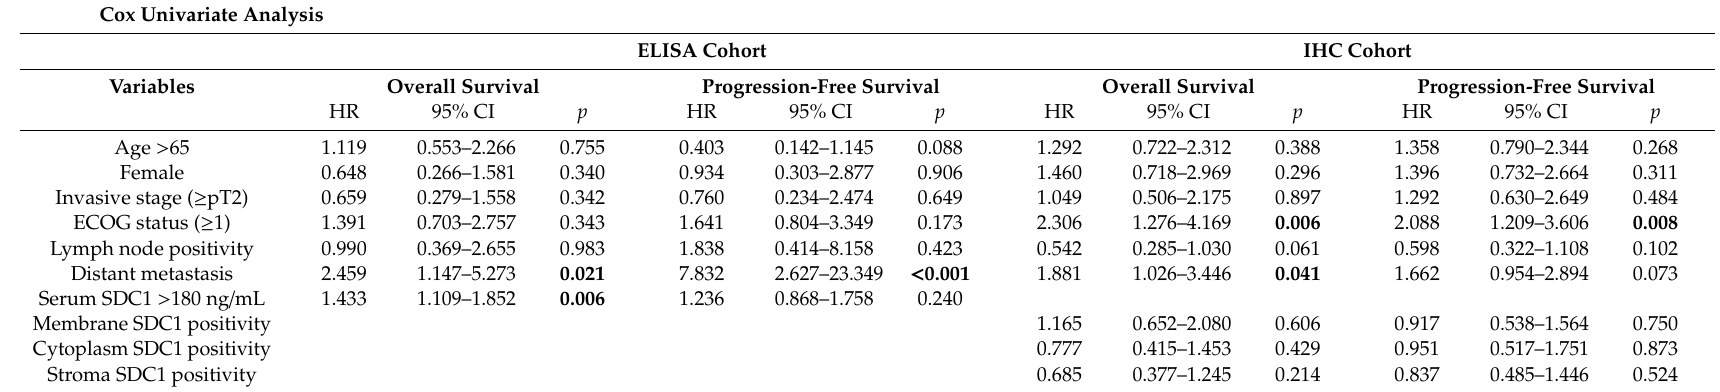
Table 3. Cox univariate overall survival (OS) and progression-free survival (PFS) analysis in the ELISA (serum SDC1 concentration) and IHC cohort (SDC1 expression). HR—hazard ratio, CI—confidence interval, ECOG — Eastern Cooperative Oncology Group. Bold printed p -values were significant ( <